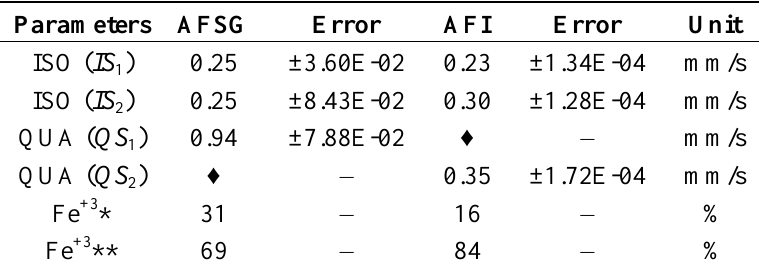
Table 3. Mössbauer parameters of AFSG and AFI. Parameters AFSG